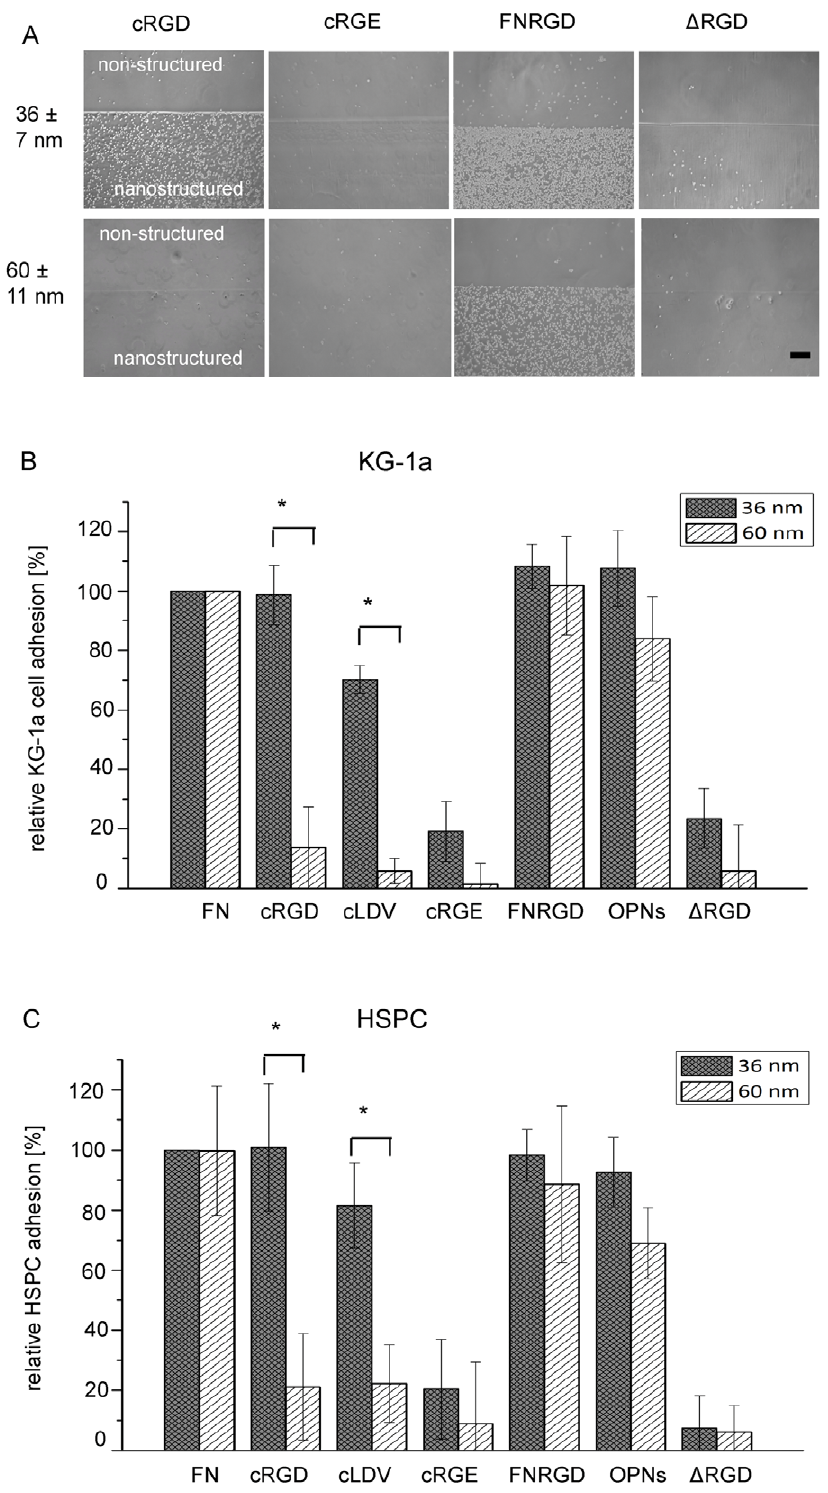
Figure 3. Adhesion of KG-1a cells and HSPC to nanopatterned, biofunctionalized PEG hydrogels. Cells were plated on hydrogels in adhesion media and evaluated by phase contrast microscopy or Cy Quant cell quantification after 1 h of incubation. (A) Microscopic images of KG-1a cells on biofunctionalized PEG hydrogels. Cells appear as bright spots on a gray background. The area in the lower part of each image is nanostructured and the upper area is unstructured (internal control). The name of the applied ligand is given above each image. Cell adhesion to NP arrays with a distance of 36 6 7 nm or 60 6 11 nm are shown in the upper and lower row of images, respectively. FN D RGD is abbreviated with ‘‘ D RGD’’. One representative experiment out of 4 is shown. Scale bar=200 m m. (B) Relative quantification of KG-1a cell adhesion and (C) HSPC adhesion to different ligands on NP arrays with 36 6 7 nm (filled columns) or 60 6 11 nm (diagonally striped columns) spacing. On the y-axis the number of